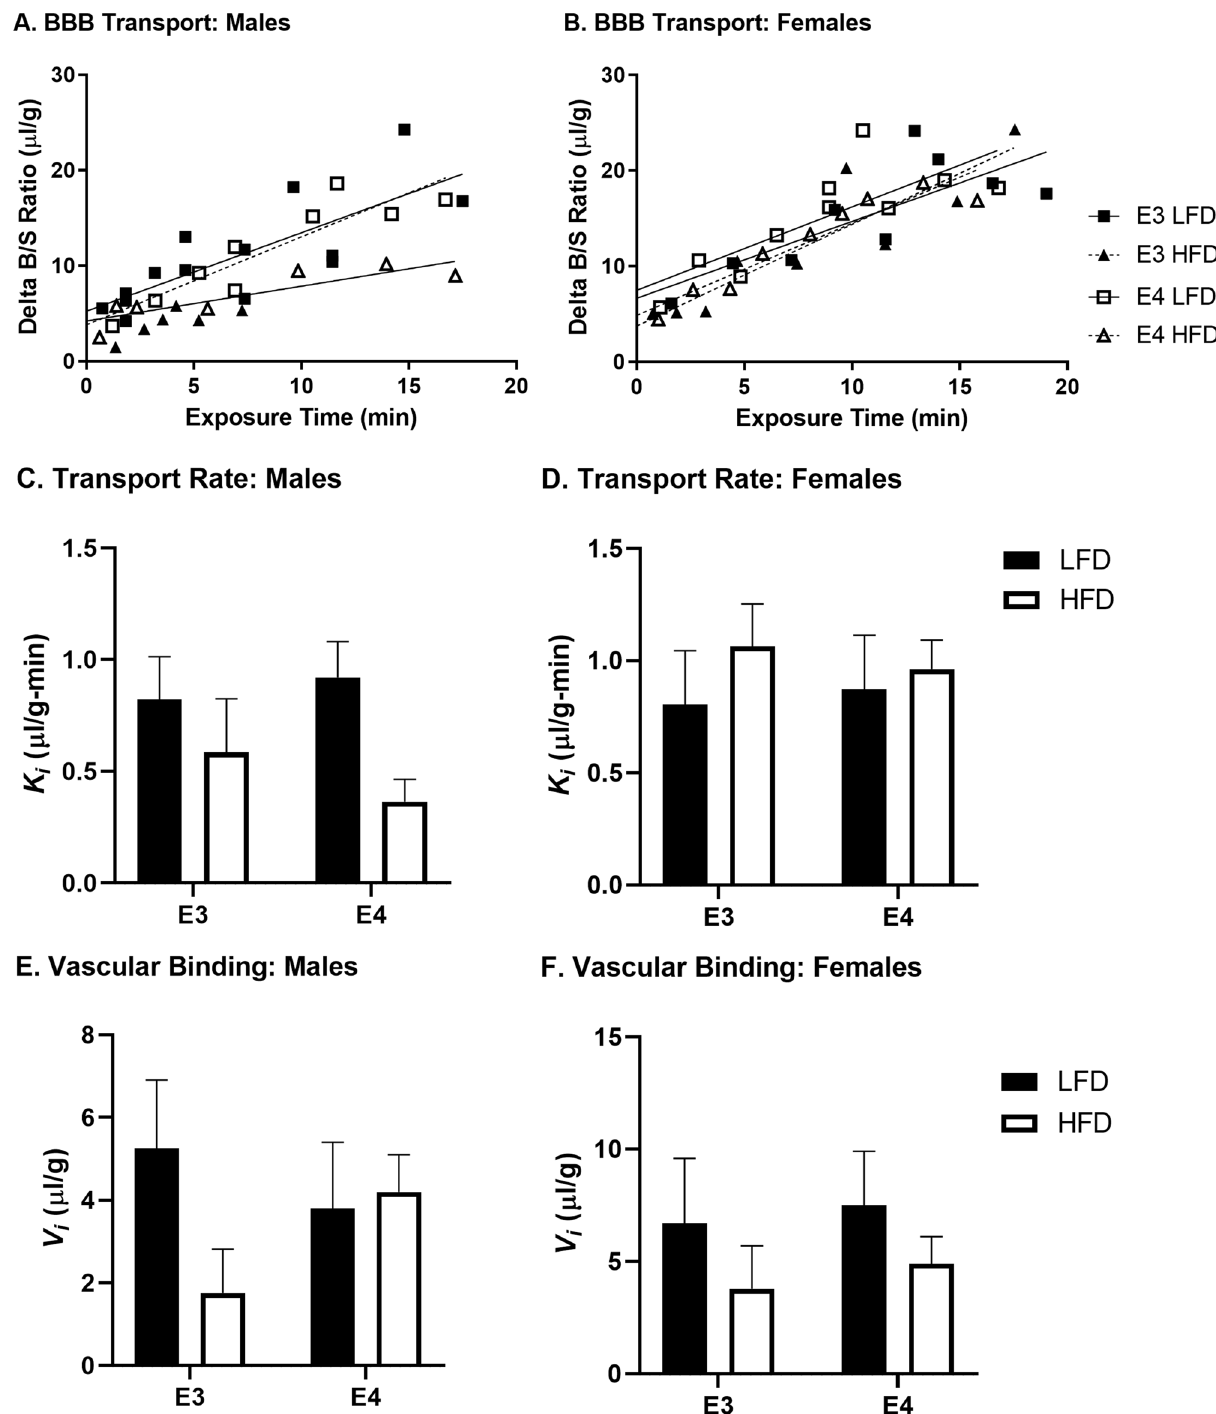
Figure 5. 125 I-insulin BBB transport. Delta B/S values are plotted against exposure time for ( A ) males and ( B ) females. 125 I-insulin BBB transport rates ( K i ) are calculated from the curves in A/B for ( C ) males and ( D ) females. Males have decreases ( p = 0.056) in BBB transport due to HFD while females do not. The level of 125 I-insulin vascular binding ( V i ) was affected by apoE isoform and diet in ( E ) males ( p < 0.01) but not in ( F ) females. There were not post-hoc